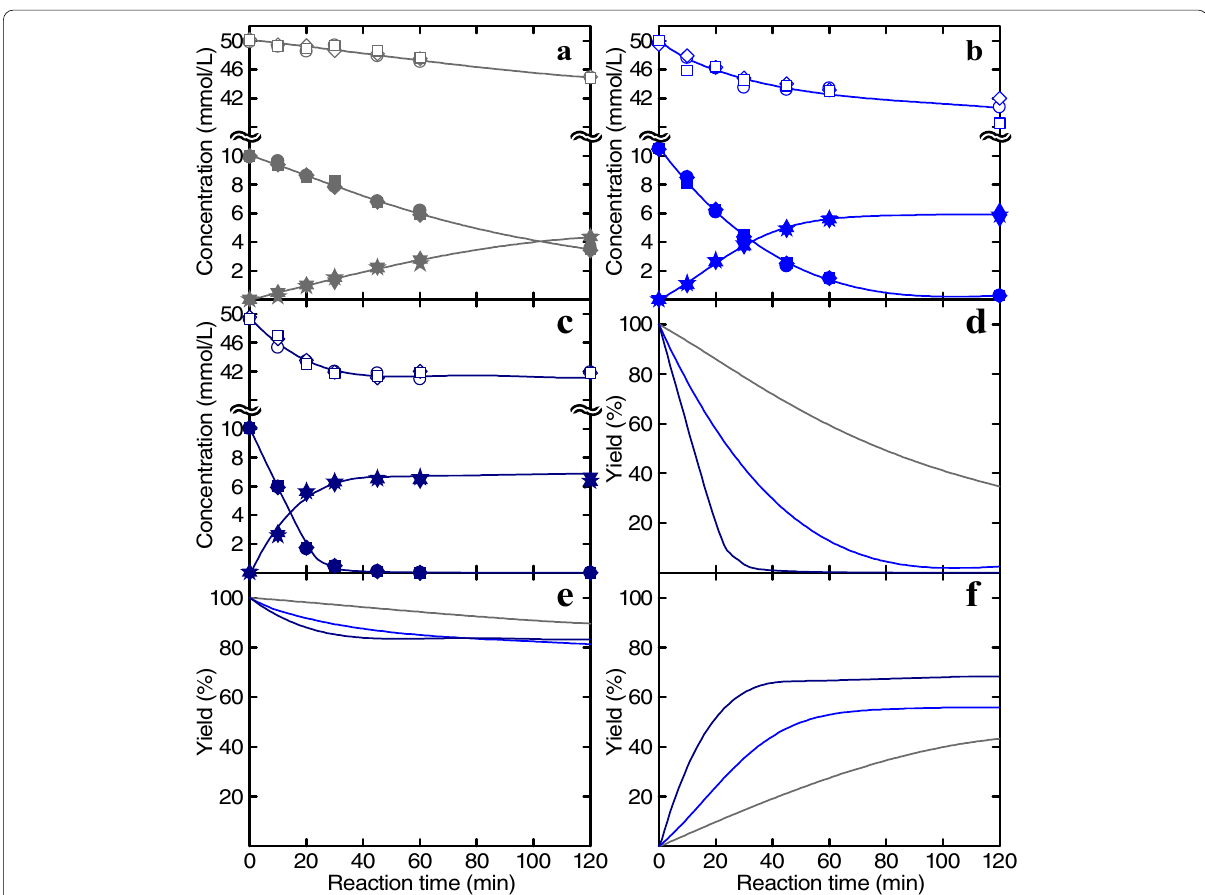
Fig. 7 Time courses of the changes in the recovery yields of Va (filled circles, filled diamonds, and filled squares) and Cr (open circles, open diamonds, and open squares), and yield of VaCr (filled stars, filled triangles, and filled inverted triangles) in the systems. a 130 (solid grey lines), b 150 (solid blue lines), and c 170 (solid dark blue lines), and in the recovery yields of Va ( d ) and Cr ( e ), and in the yield of VaCr ( f ). Filled circles, open circles, and filled stars show the 1st trial. Filled diamonds, open diamonds, and filled triangles show the 2nd trial. Filled squares, open squares, and filled inverted triangles show the 3rd